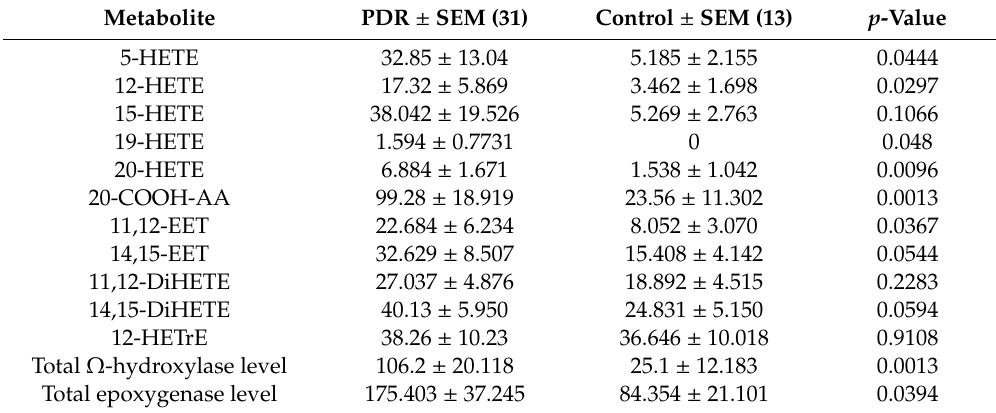
Table 1. Mean levels (pg / mL) ± standard error of measurement (SEM) in human vitreous of lipoxygenase and cytochrome P450-derived eicosanoids in proliferative diabetic retinopathy (PDR, n = 31) versus controls ( n = 13).